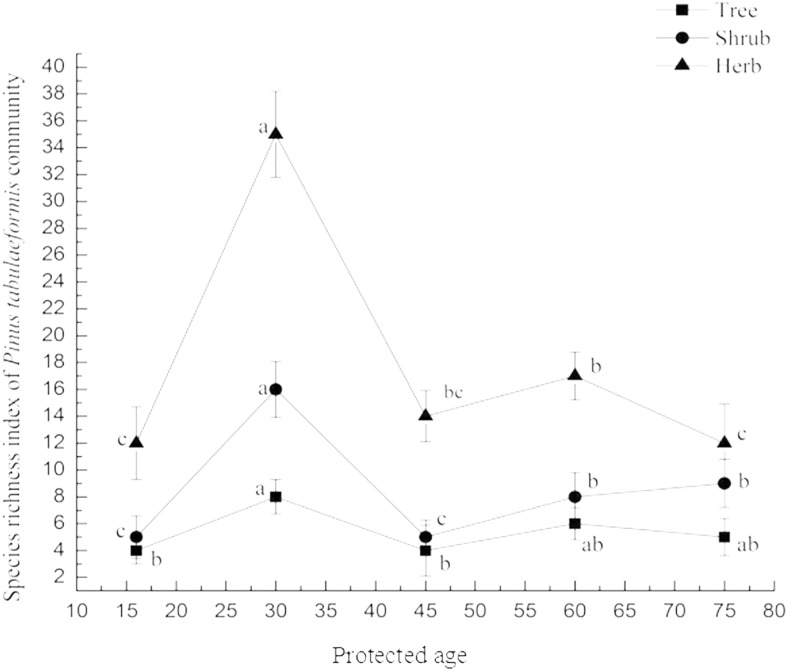
Richness of Pinus tabulaeformis community in protected stands.The values are the mean ± SD. Different letters in the same layer in the figure indicate significant differences between groups based on LSD (p < 0.05). Confidence interval of 95% for richness of tress, shrubs and herbs among protection years is [3.32,7.48], [2.03,14.37] and [5.93,30.07] respectively.